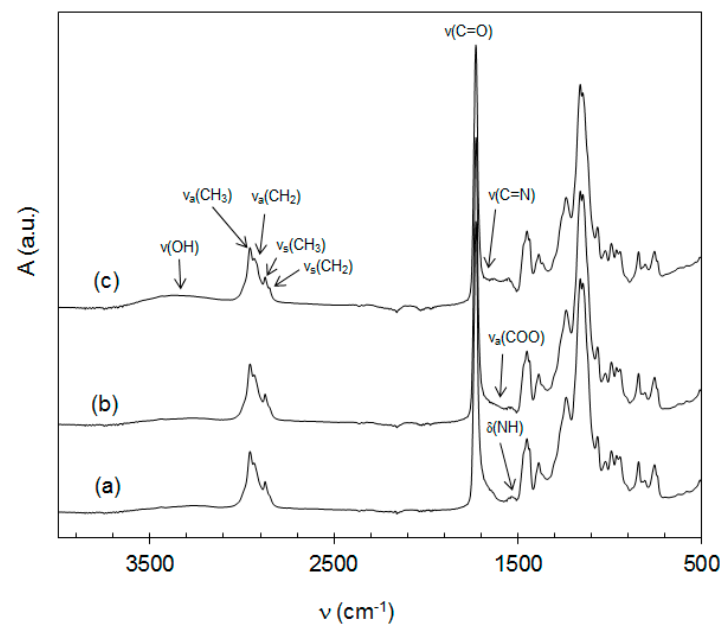
Figure 4. FT-IR spectra of latex materials: ( a ) sample L 0 without nanoparticles; ( b ) sample L ZnO-2.0 containing ZnO-originated nanoparticles; ( c ) sample L MgO-2.0 containing MgO-originated nanoparticles.